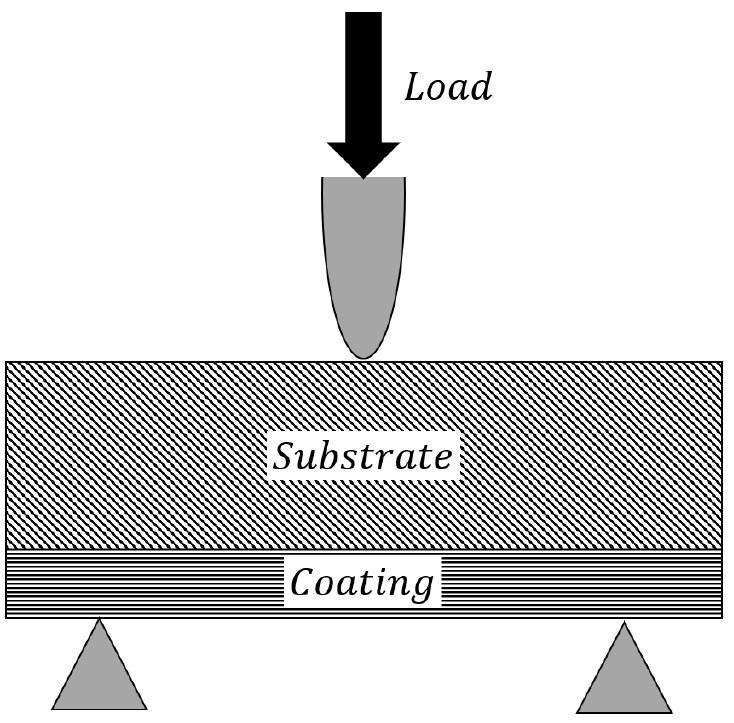
Figure 1. Three-point bending test configuration.